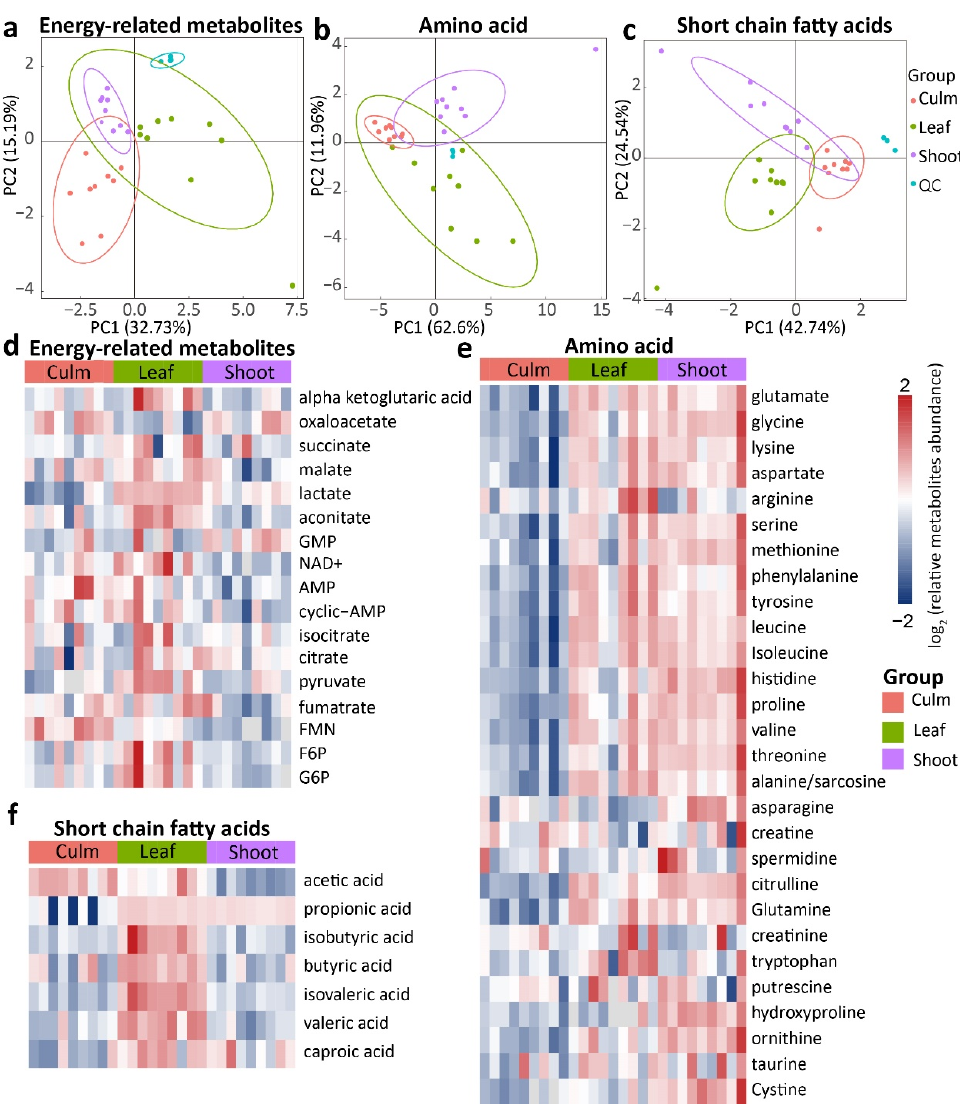
Figure 3. Results of three targeted metabolomics analyses of giant panda fecal samples. ( a – c ) Scatter plot of partial least squares discrimination analysis (PLS-DA) scores of fecal metabolites in giant pandas under di ff erent dietary conditions. ( d – f ) Heatmap of targeted fecal metabolites in giant pandas. Each row in the graph represents a metabolite, and columns of the same color represent a group of samples. Red represents signi fi cant up-regulation, blue represents signi fi cant down-regulation, and color depth represents the degree of up-regulation.